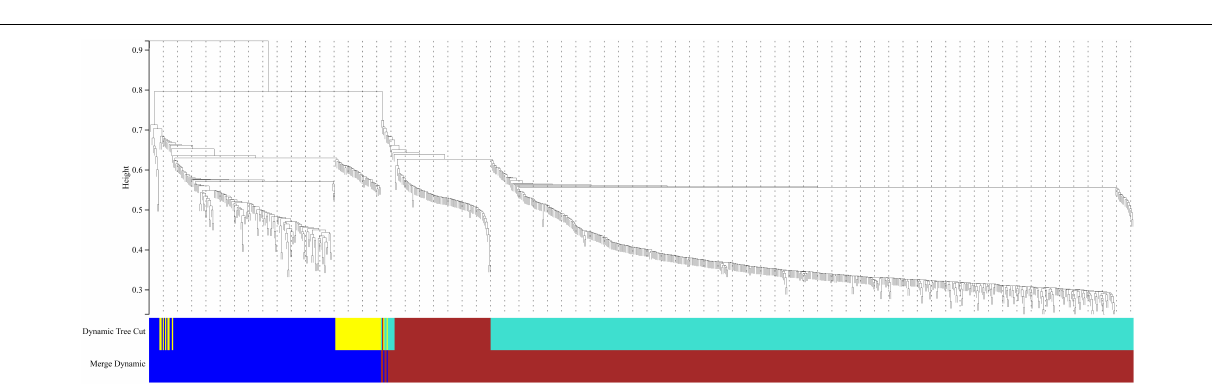
DNA methylation on the expression of genes, GSE97760